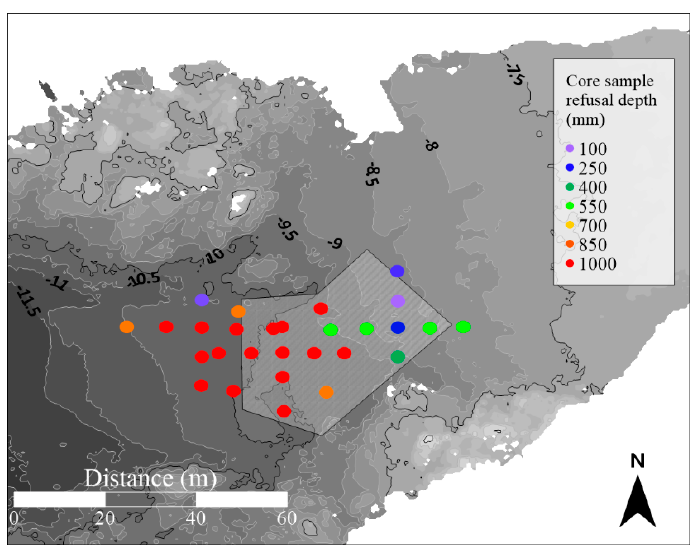
Figure 2. Location of the cores taken inside and outside of the primary survey area. Original survey polygon is depicted in the centre faded region. Coloured points depict sediment core locations measured at the cardinal point from a central georeferenced star picket at three locations. Colours represent penetration depth (in mm) before refusal when hitting a harder substrate.